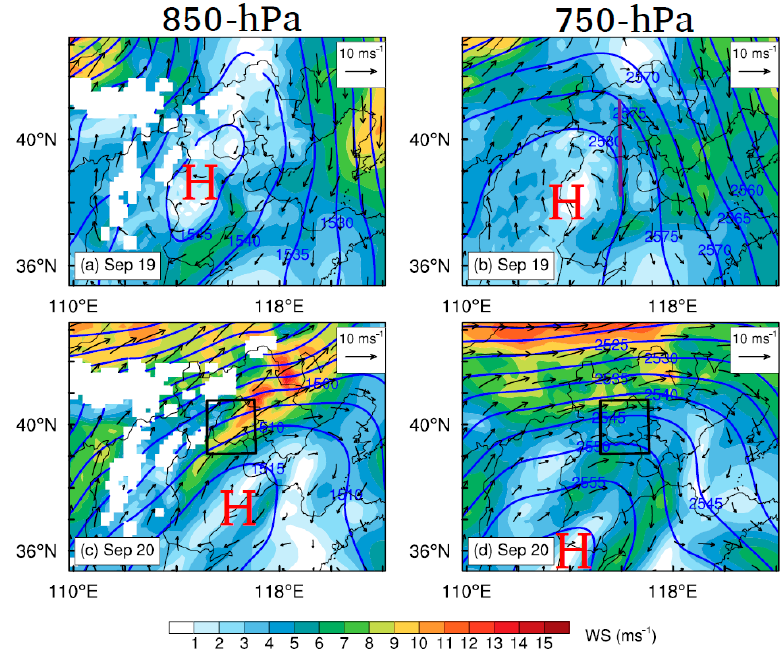
Figure 6. Simulated geopotential height (blue lines) and wind speed (color shaded) fields at (left) 850-hPa and (right) 750-hPa level at 11:00 h BJT on ( a , b ) 19 September and ( c , d ) 20 September 2015. The text “H” marks the approximate locations of the high pressure system. The violet solid line in ( b ) denotes the locations of vertical cross sections shown in Figure 7.